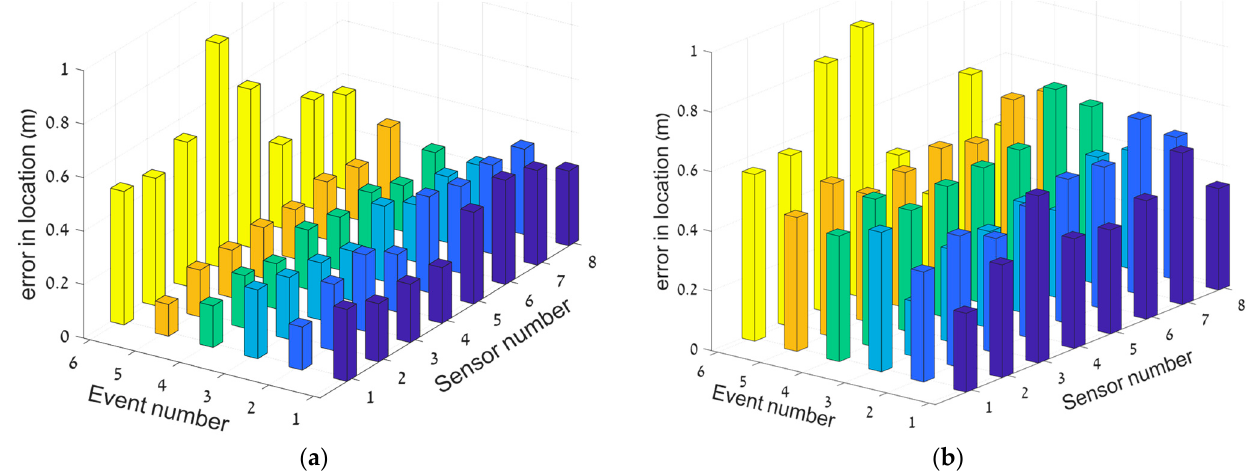
Figure 7. Deviation from exact location (in m) for each event and for each sensor. ( a ) and ( b ) are the best (MOGA) and the worst (SOPSO) results, respectively.